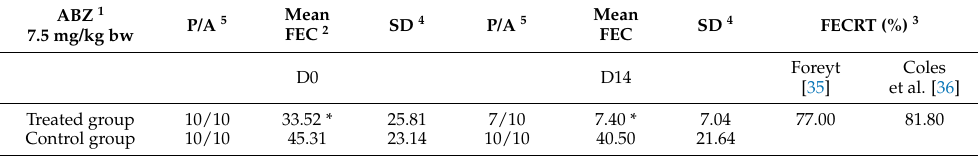
Table 1. Mean FEC and percent reduction of F. hepatica eggs for the two methods of calculation.